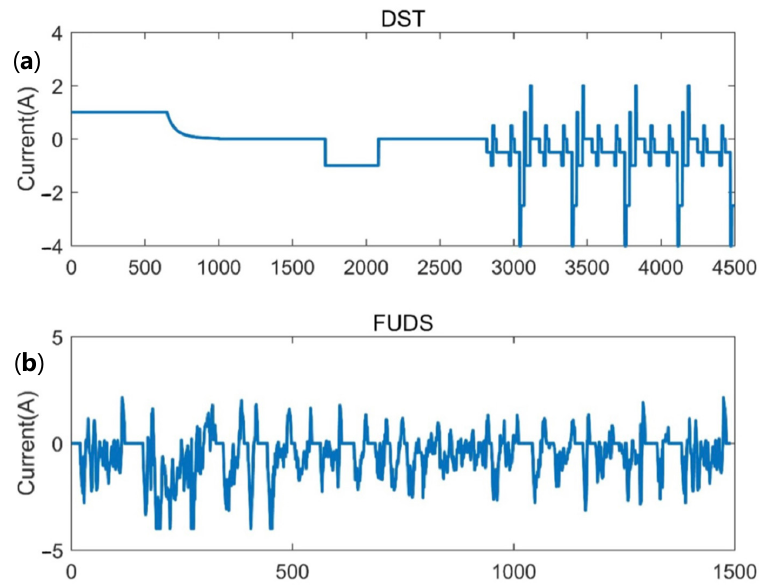
Figure 5. Battery test load curve: ( a ) Dynamic stress test; ( b ) federal urban driving schedules.